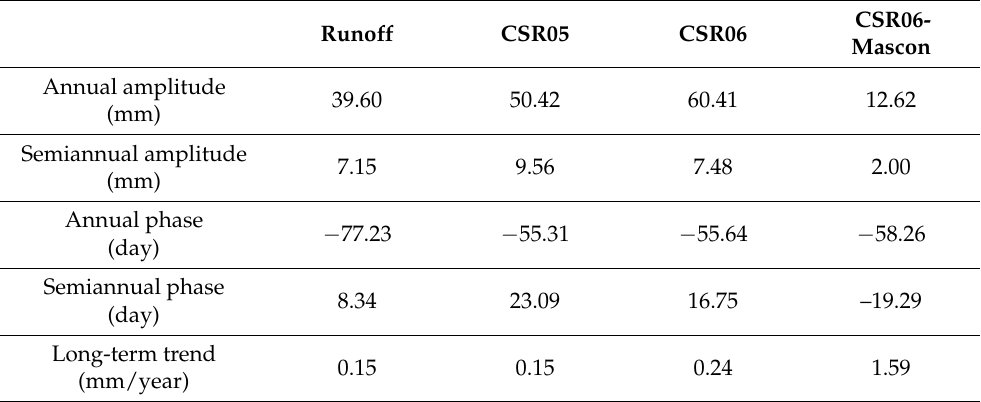
Table A2. Annual and semiannual amplitude and phase, long-term trend of runoff and three EWHs, from 2005 to 2012.